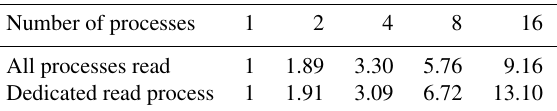
Table 3. Computational speedup S for up to 16 processes (single- node experiment) for the two different MPI modes, with 40 million released